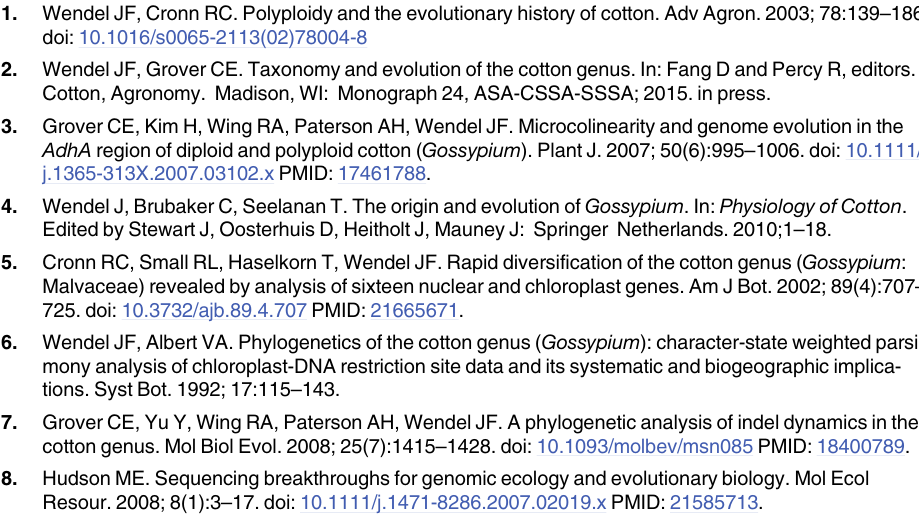
colors indicate the maximum distance and NA indicates that there exists overlap sequences between two genes. clpP and ycf3 both contain two introns, while we merged them into one. S6 Table. Indel length description and Indels data matrix for phylogenetic analysis. Note: Indels were coded as unordered characters with binary states (in the case of simple presence/ absence indels) or multistate characters (in the case of indels with variable length but one iden- tical 5 ’ or 3 ’ end). S7 Table. Indels that discriminate Gossypium cp genomes. Note: The upper triangle shows the number of indels in protein-coding exon regions and the lower triangle shows the number of indels in non-coding regions. The repeated sequences, naturally, sometimes complicate the = G . herbaceum , A = alignment process, so we excluded the IR region from the analysis. A 1 1-a G . africanum , A = G . arboreum , AD = G . hirsutum , AD = G . barbadense , F = G . longicalyx , 2 1 2 1 = G . stocksii , E = G . somalense , E = G . areysianum , E = G . incanum , D = G . thurberi , E 1 2 3 4 1 = G . raimondii , D = G . gossypioides , B = G . anomalum , B = G . capitis-viridis , C = G . stur- D 5 6 1 3 1